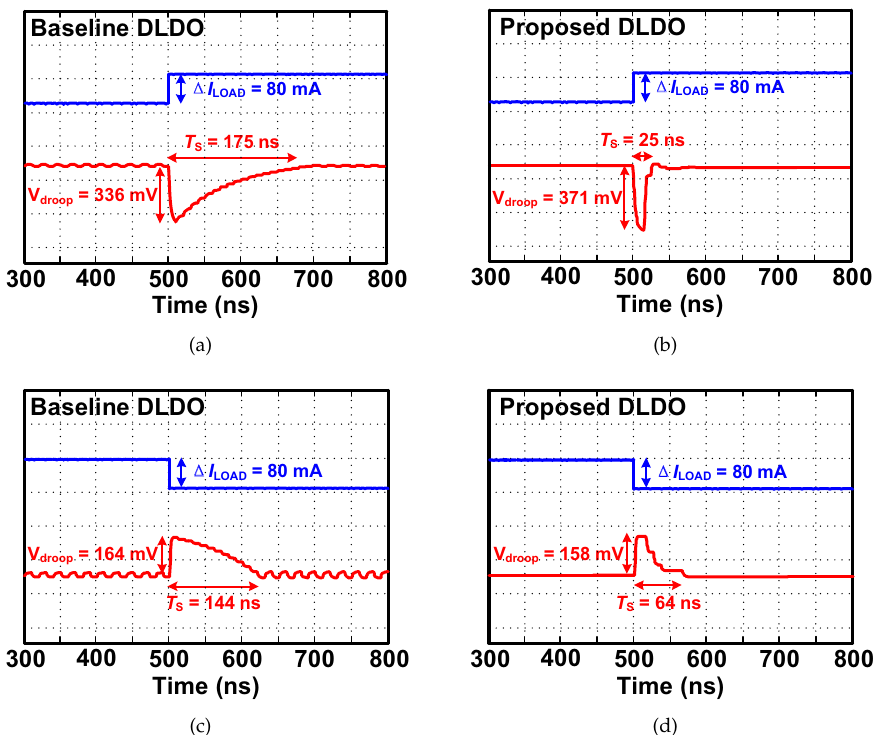
Figure 13. The measured transient responses of the baseline DLDO and the proposed DLDO for a load: step up ( a , b ); and step down ( c , d ).